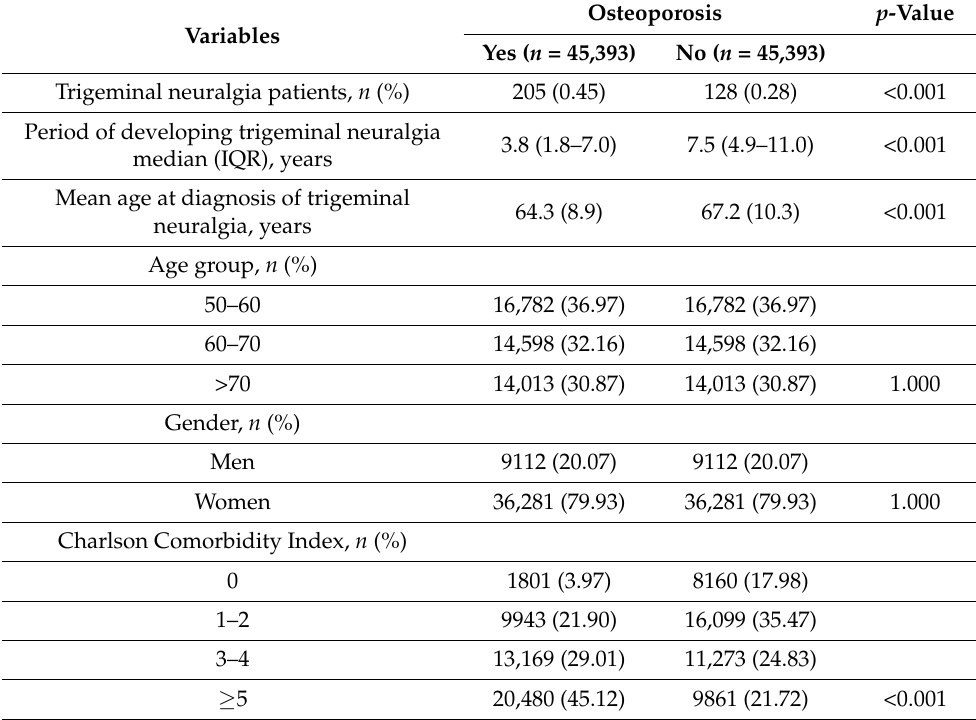
Table 1. Baseline characteristics between people with and without